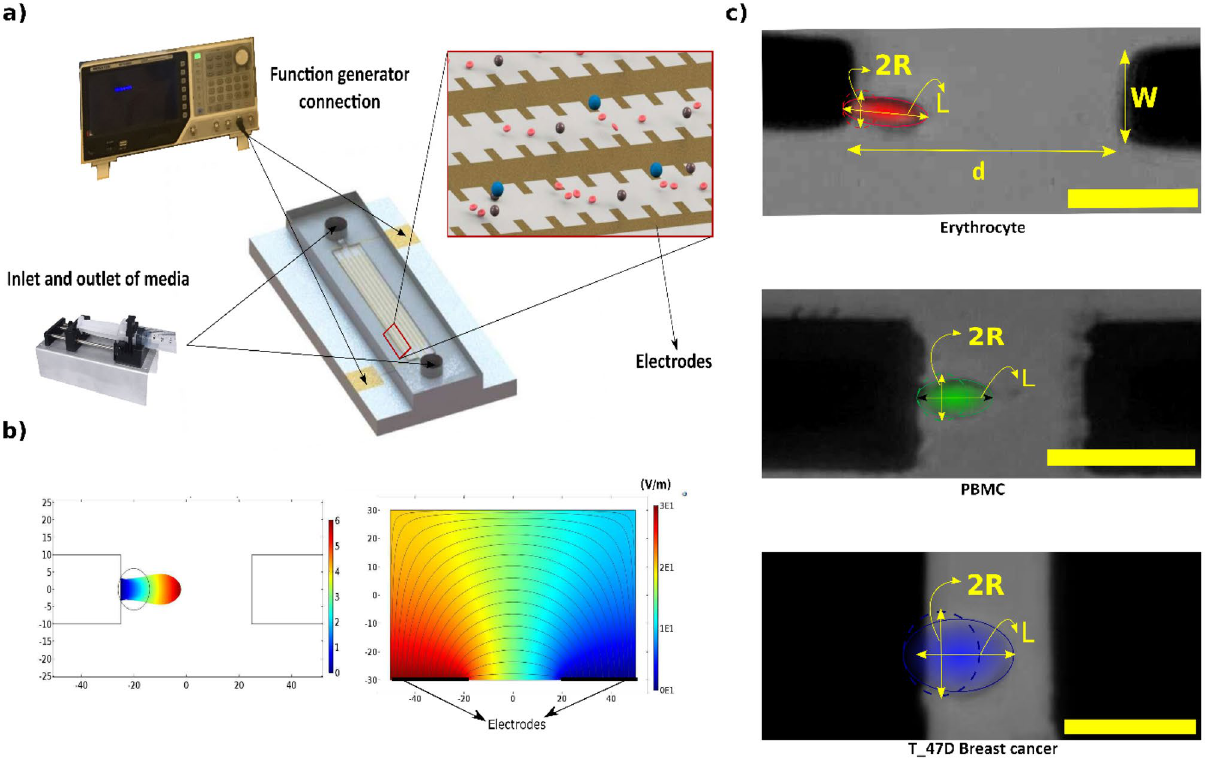
Figure 1. Operational principles of our proposed microfluidic chip ( a ) Schematic image of the microfluidic device and experimental setup. ( b ) Simulation results in single-cell deformation and electric field and electric field gradient in the channel’s height. ( c ) Experimental pictures of elongated Erythrocyte, PBMC, and T-47D cells. The scale bar is 30